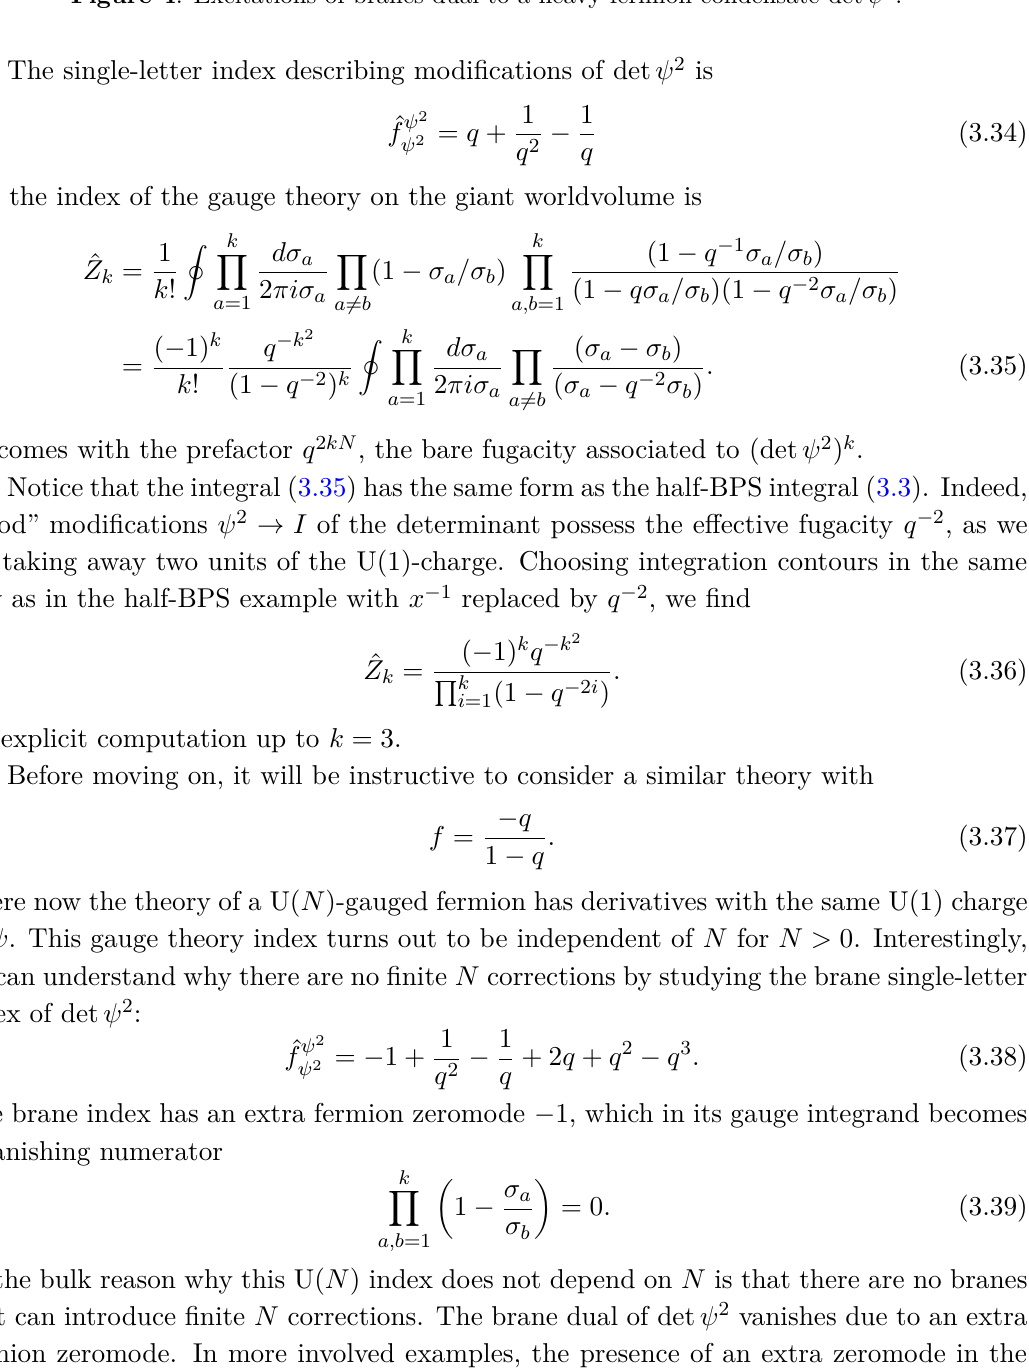
Figure 4 . Excitations of branes dual to a heavy fermion condensate det ψ 2